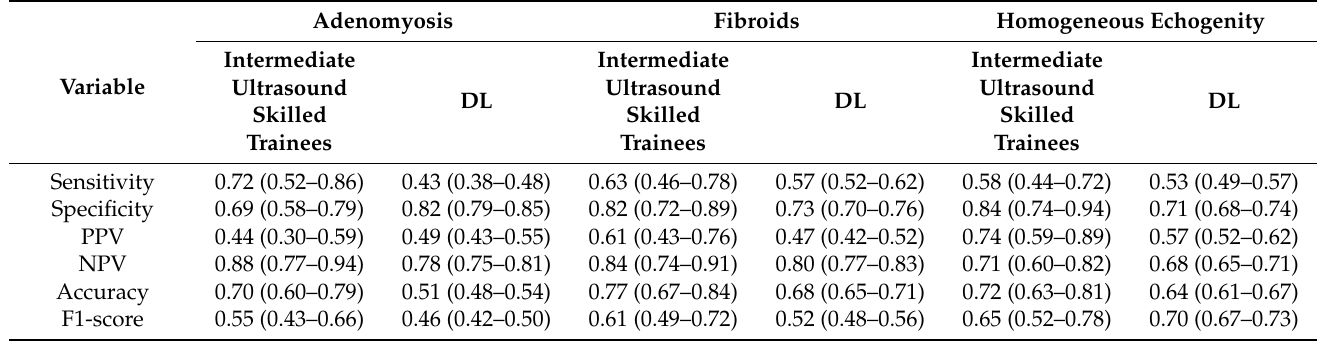
Table 3. Diagnostic performance of intermediate ultrasound skilled trainees and DL in the diagnosis of homogeneous echogenicity, fibroid and adenomyosis in the testing